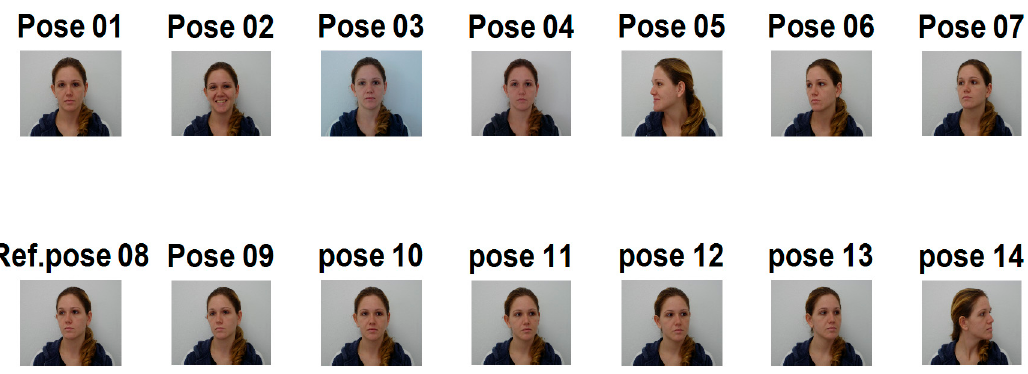
Figure 6. Poses for person No. 15 in FEI database.